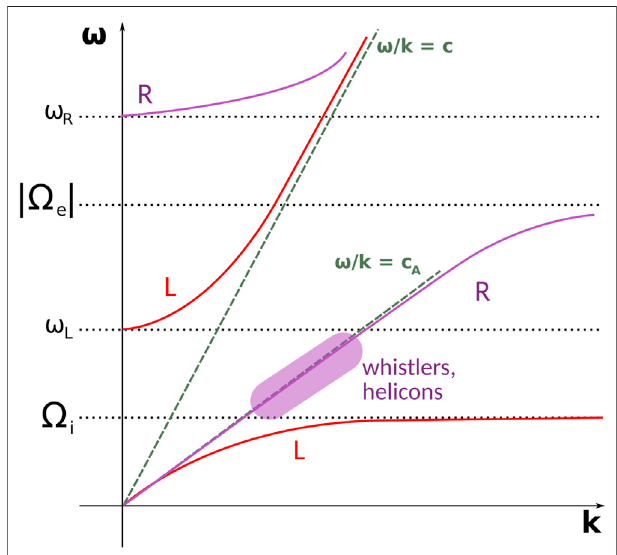
FIGURE 2 | Location of whistlers and helicon plasma waves, among cold plasma waves propagating parallel to the externally-applied magnetic fi